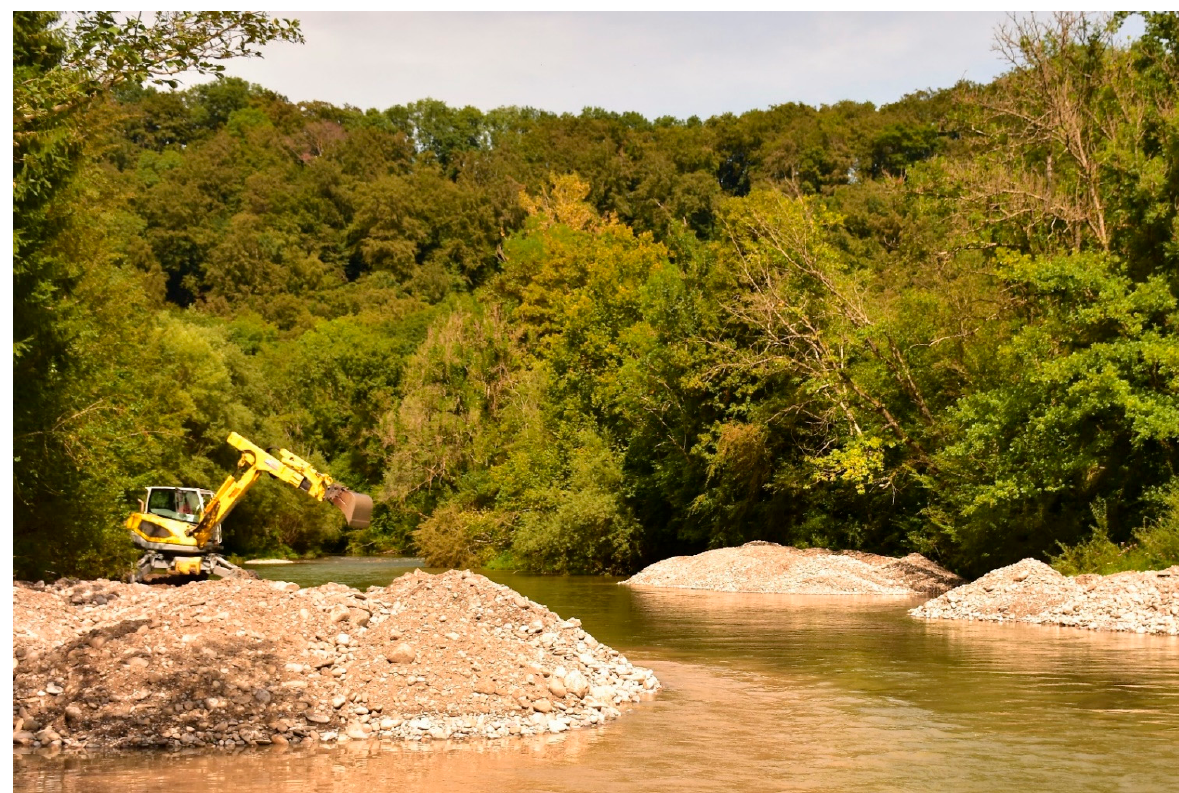
Figure 3. Installation of in-channel stockpiles at the residual flow section of the Sarine River, downstream of Rossens Dam, Switzerland, in 2016. About 1000 m 3 of an alluvial sediment mixture from the adjacent floodplain were injected and coupled with an artificial flood to improve the downstream riverbed structure and increase habitat diversity.